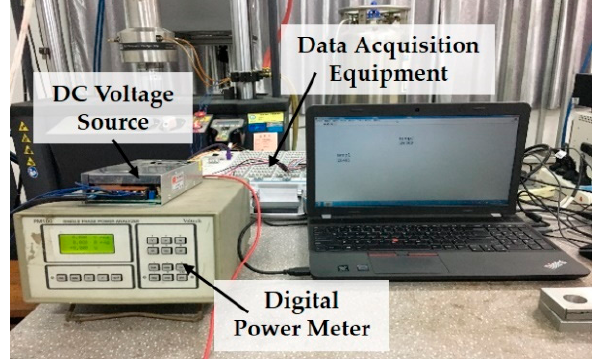
Figure 4. Measurements of temperature, strain and electric resistance.